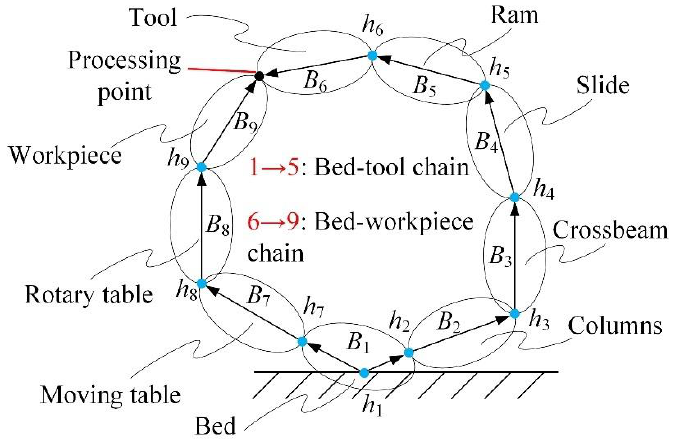
Figure 3. The topological structure of the HDVMC.